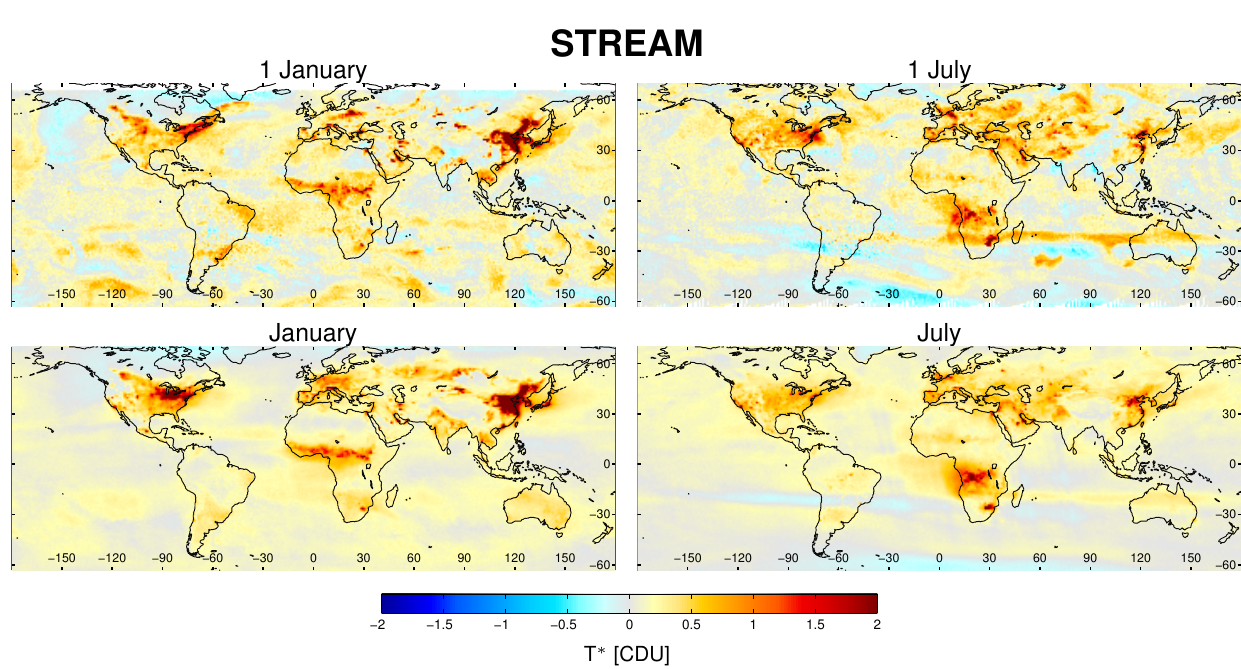
Figure 5. OMI tropospheric residues T ∗ based on STREAM for January (left) and July (right) 2005 for the first day of the month (top) and the monthly mean